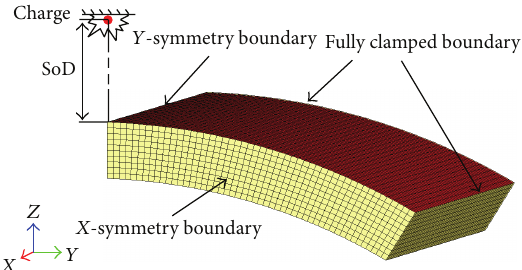
Figure 2: Loading and boundary conditions and meshes for 1/4 model of the curved sandwich